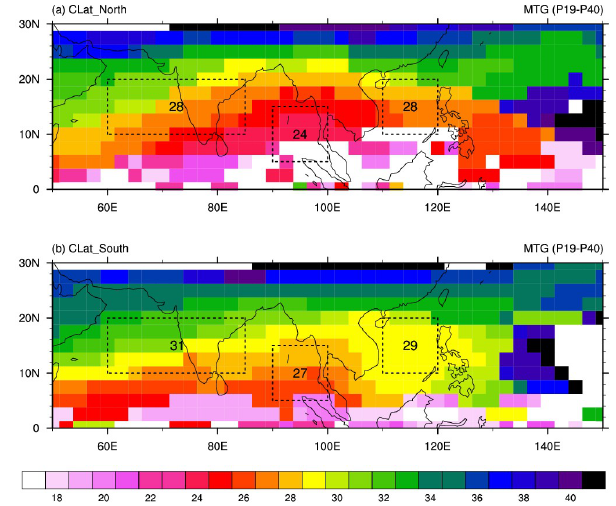
Figure 8. Composite transition pentads of the MTG from negative to positive in the ( a ) North and ( b ) South track cases (shading; units: pentad). Dashed boxes from West to East indicate the regions of the ISM, BOB and SCS, respectively. Number inside each box is the domain average of the MTG transition pentads.